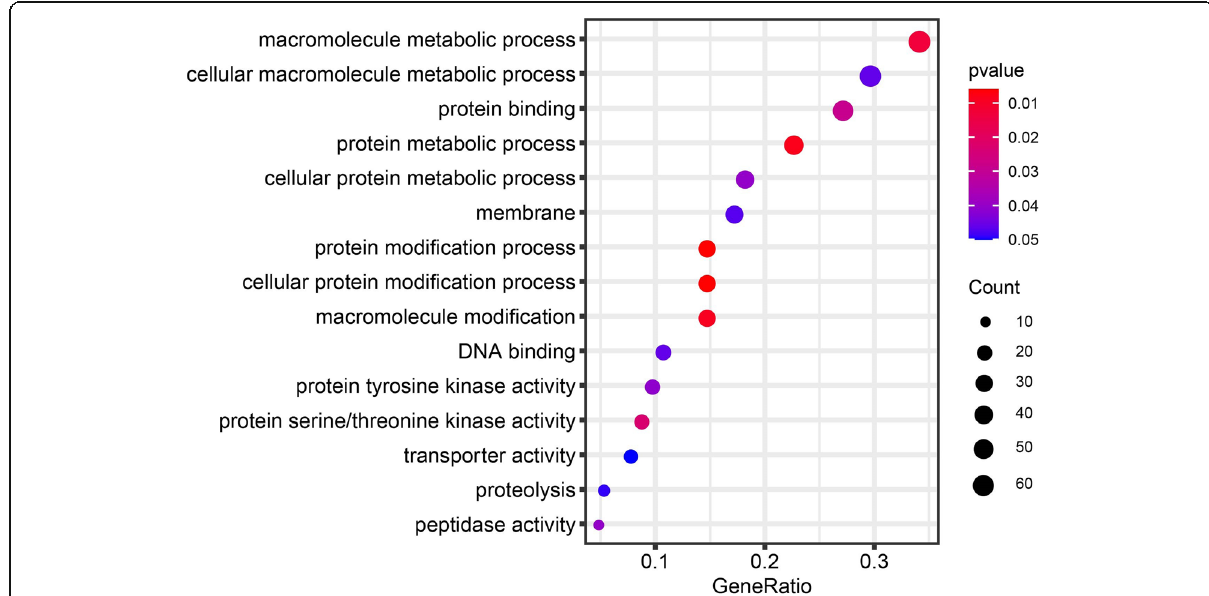
Fig. 3 GO analysis of candidate genes of fiber quality